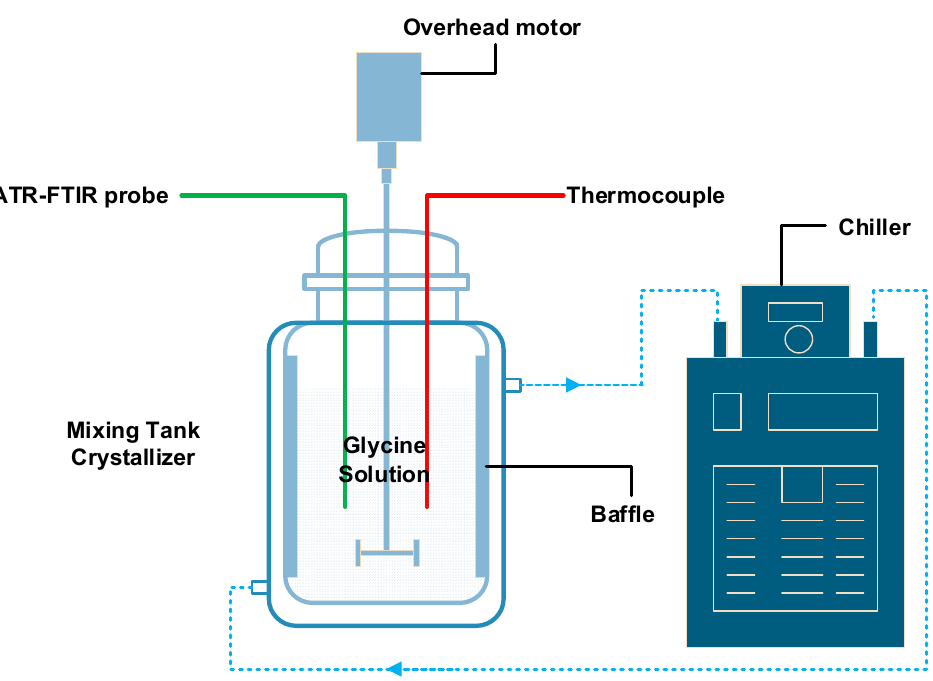
Figure 1. Schematic of the experimental setup in the mixing tank crystallizer consisting of in situ ATR-FTIR and a thermocouple probe.